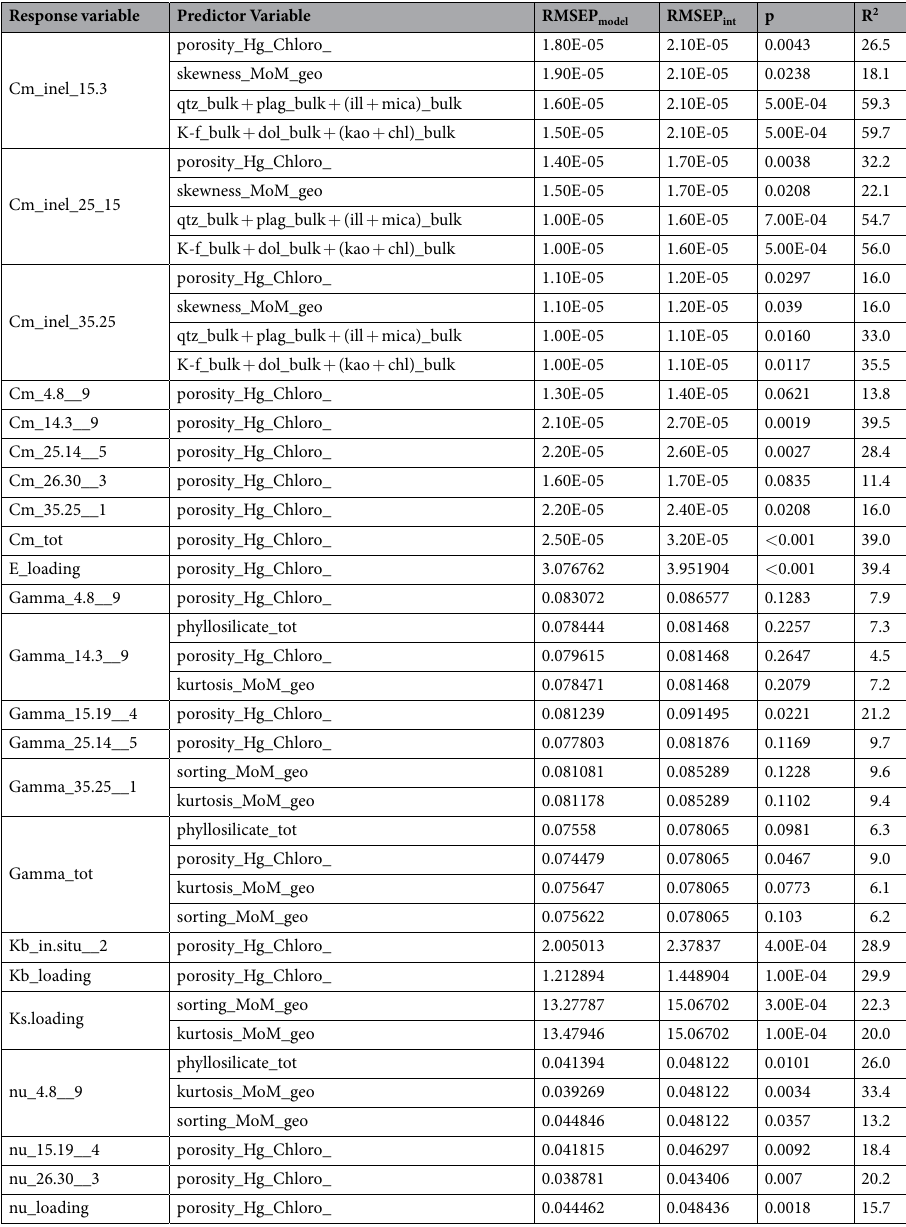
Table 1. Overview of variables tested using univariate statistical models. Nomenclature: Cm = uniaxial-strain compressibility, inel = inelastic, el = elastic, prefix “15–3” indicates a pore pressure step, in this case from 15 MPa to 3 MPa pore pressure, Gamma = γ h , tot = total averaged over the complete pore pressure depletion step from 35 MPa to 3 MPa, nu = ν , which is the Poisson’s Ratio, MoM = Method of Moments, geo = geometric, Hg = determined using Mercury immersion method, chloro = determined using chloroform immersion method, the prefix “#9” indicates the sequential number of the pore pressure depletion or inflation cycle in the UPPD/M protocol. Minerals are indicated with “qtz” for quartz, “plag” for plagioclase, “dol” for dolomite, “K-f” for K-feldspar, “ill” for illite, “mica” for mica, “kao” for kaolinite, “chl” for chlorite, where the prefix “bulk” refers to the XRD analysis conducted using the bulk crushed